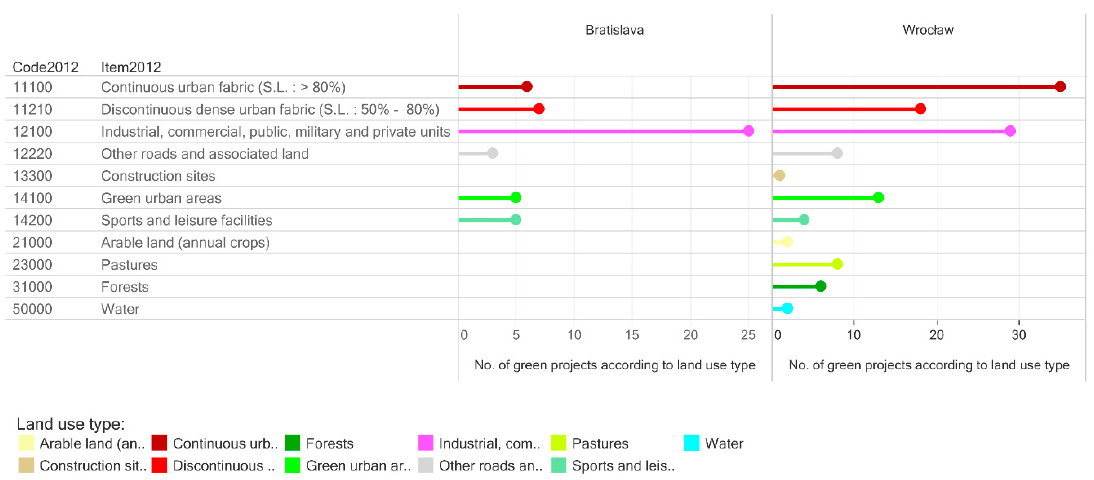
Figure 4. The comparison of projects implemented in Bratislava and Wrocław according to land use type. Source: Own elaboration using Tableau software .